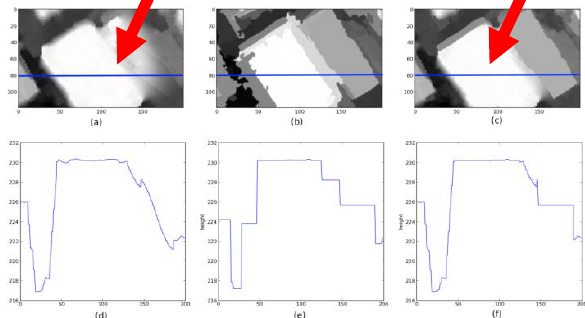
Figure 3(c) is the refined DSMs with restriction check.